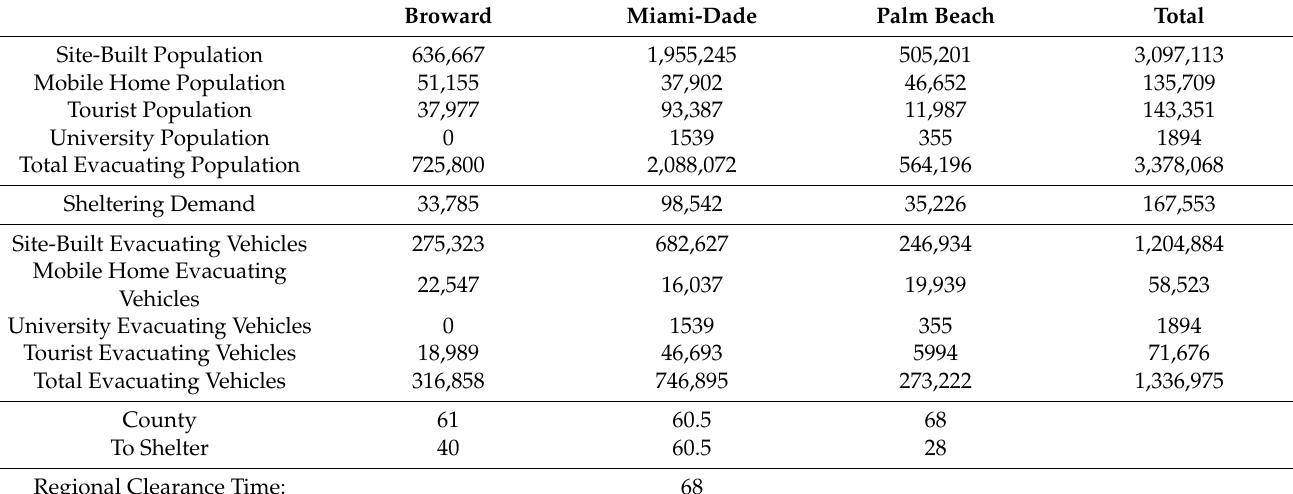
Figure 8. Roadways with a higher risk of inundation. Table 4. Evacuation demand and clearance